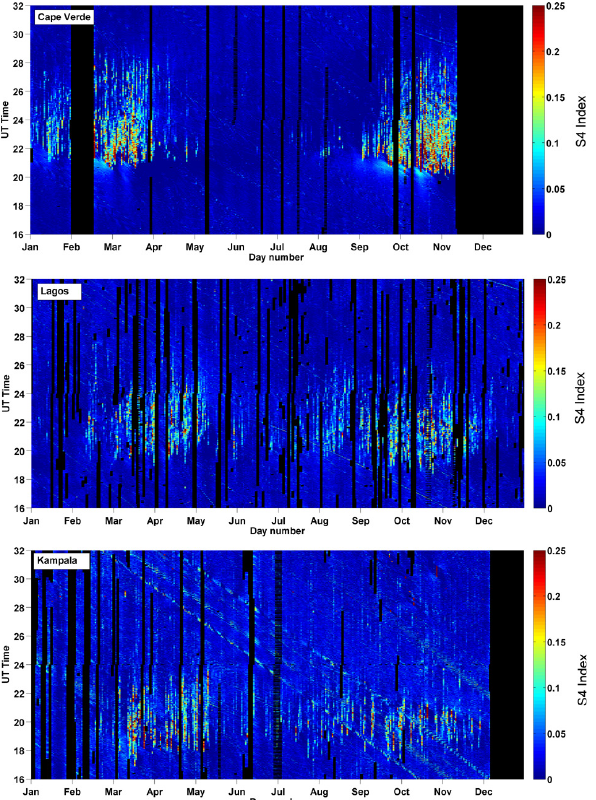
Fig. 3. Example of GPS scintillation data for the year 2010 from three regions: Cape Verde, Lagos, and Kampala. The graphs show distribution of the S4 index measurements as function of day of the season and universal time. Black color has been used to indicate missing